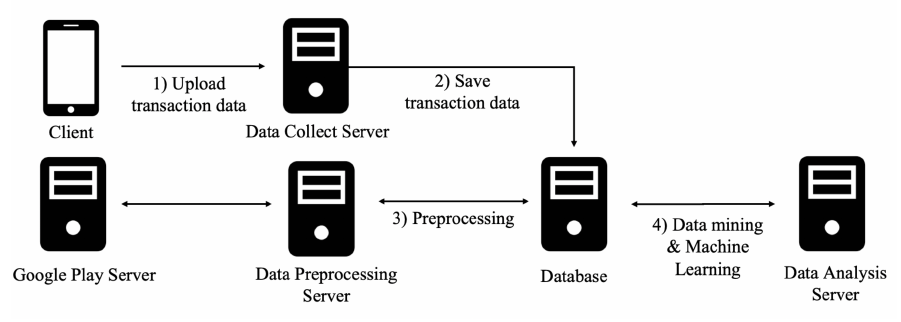
Figure 2. Proposed server